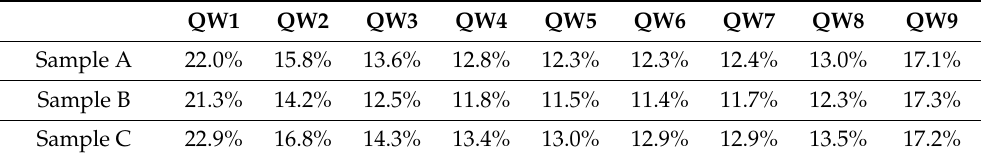
Table 2. Wavefunction overlap in each QW for sample A, sample B and sample C.